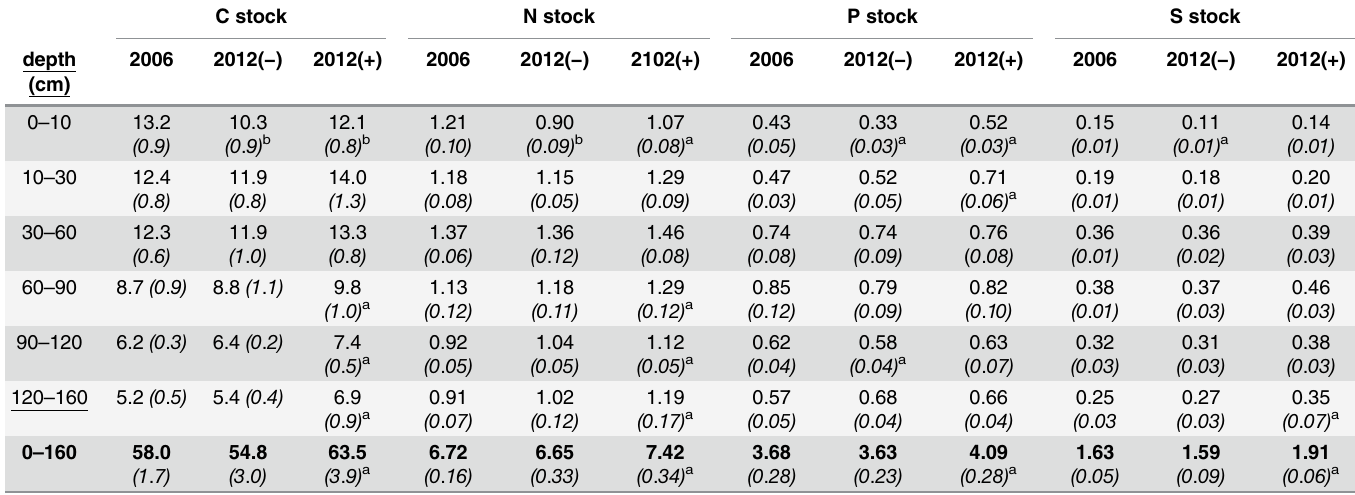
Table 3. FF-C, -N, -P and -S stocks (t ha -1 ) at the Harden field site in 2006 and for the ( − ) and (+) nutrient treatments in 2012. Data are means and SEM. n = 4 .